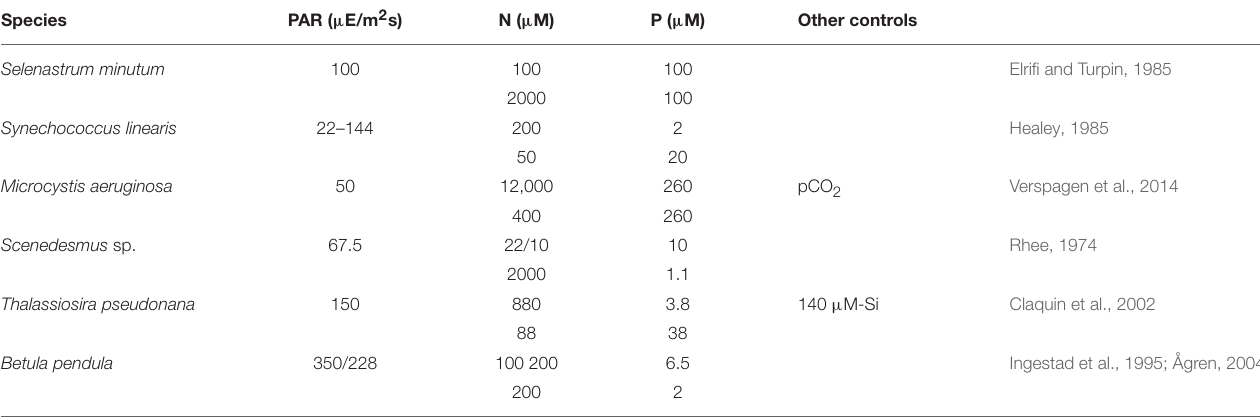
TABLE 1 | Settings of chemostat experiments at different photosynthetically active radiation (PAR) levels with two pairs of input/reservoir N and P concentrations that induced either N- or P-limited growth. Species PAR ( µ E/m 2 s) N ( µ M) P ( µ M) Selenastrum